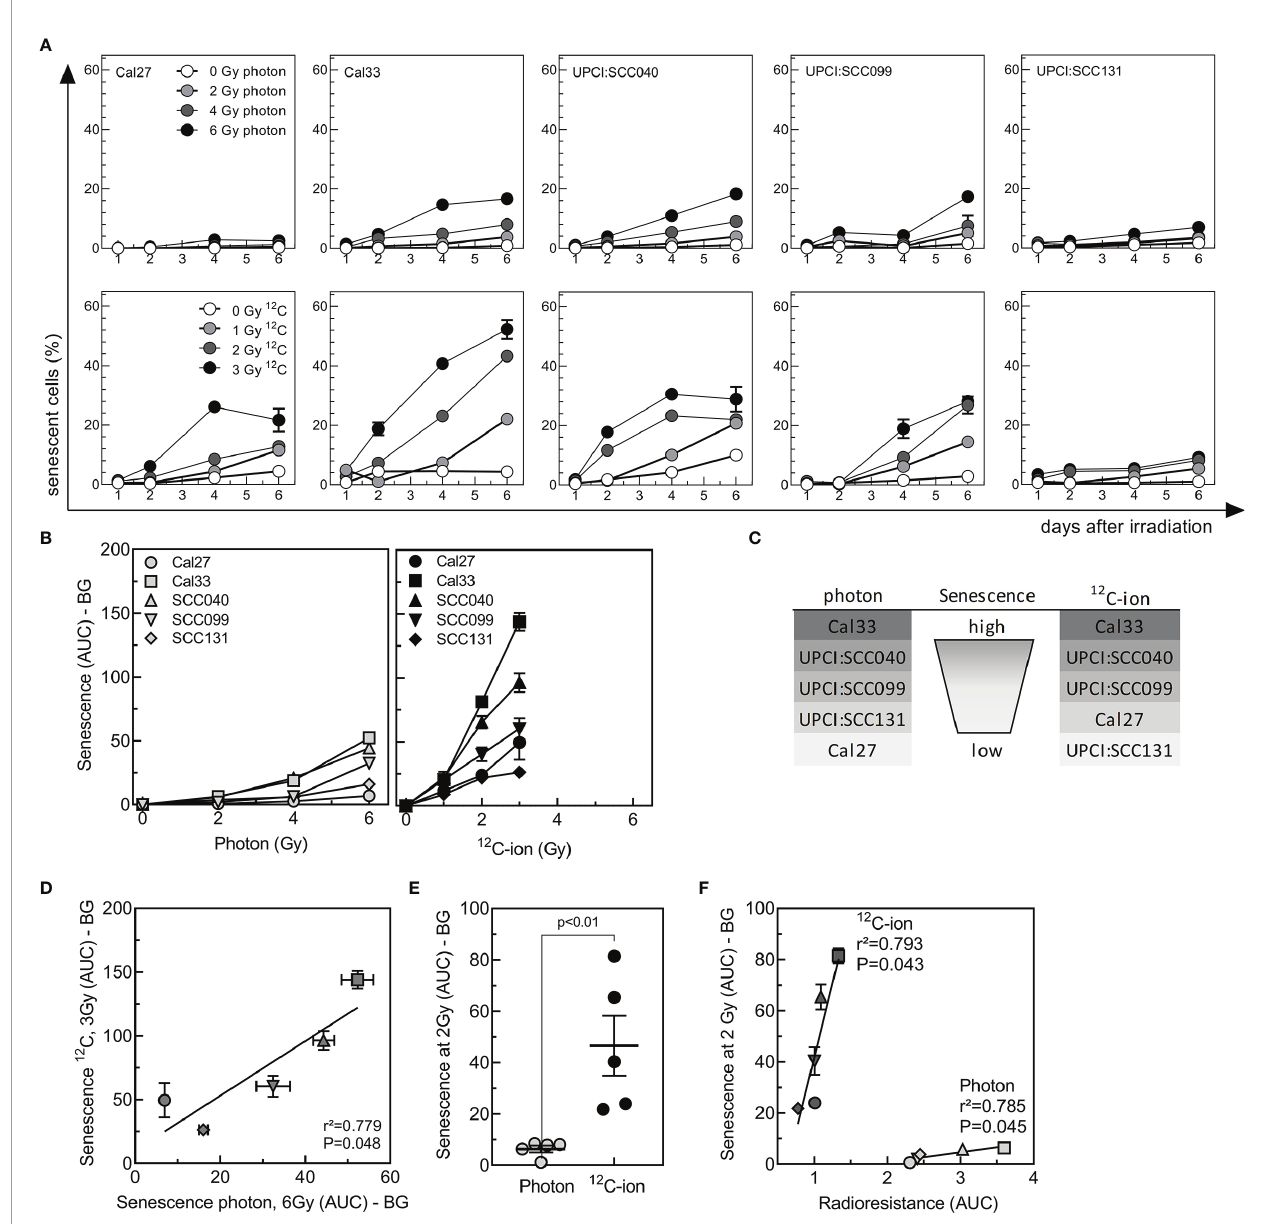
FIGURE 3 | Senescence induced by photon or 12 C-ion irradiation in HNSCC cell-lines. Cells were irradiated either with 2-, 4, or 6 Gy photons or 1-, 2-, or 3-Gy 12 C-ions, and senescence was detected for 6 days by fl ow-cytometric measurement of SA- b gal activity. (A) Kinetics of senescence as a function of dose and time after irradiation. (B) Senescence (AUC with background BG subtracted) as a function of dose. (C) Ranking of senescence induced by irradiation. (D) Correlation between senescence induced by 6-Gy photons or 3-Gy 12 C-ions. (E) Group analysis of senescence (AUC-BG) induced by 2-Gy photons or 12 C-ions. (F) Association between senescence induced by 2 Gy of photons or 12 C ions (AUC-BG) with the radioresistance (AUC) of the respective cell line. Values are indicated as MV ± SEM. p values were calculated using t-test statistics. p values < 0.05 are considered signi fi